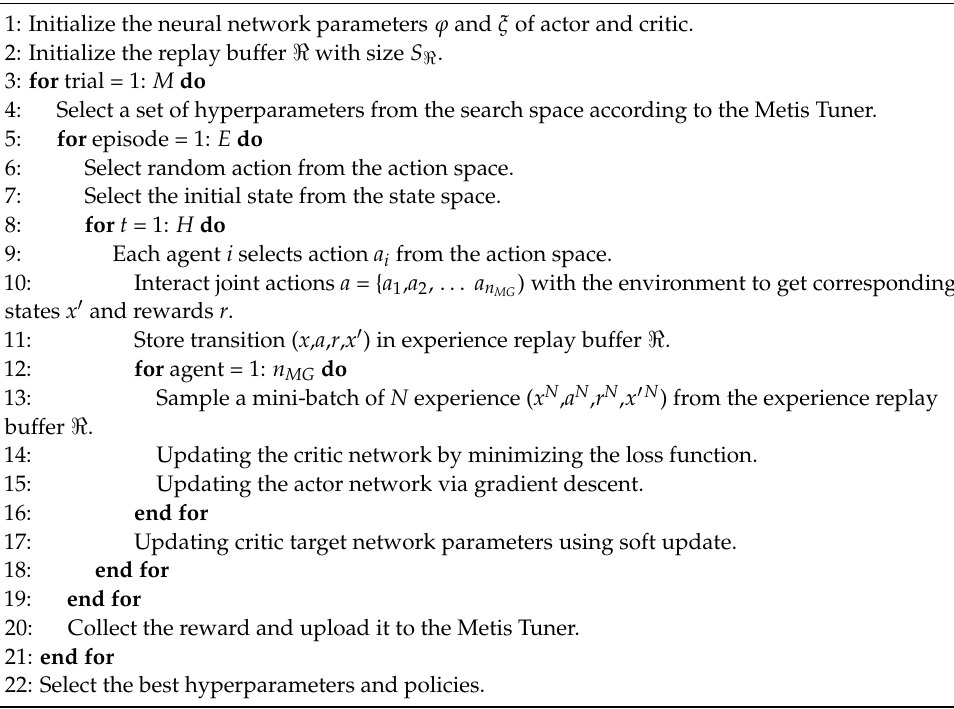
Algorithm 1: MASAC Algorithm Based on AutoML for Multi-Microgrid Optimal